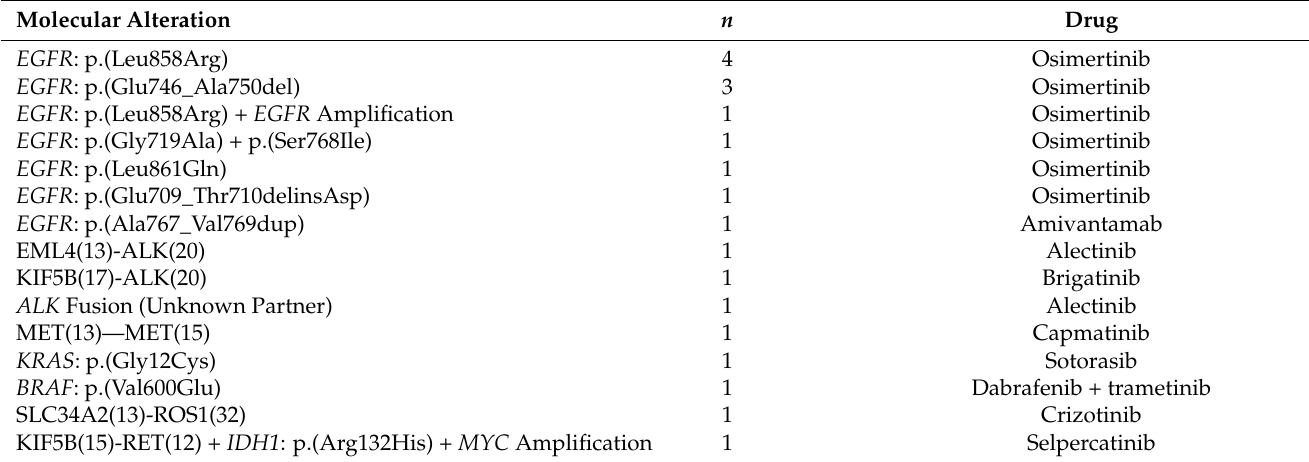
Table 2. Patients with stage IV NSCLC treated with targeted therapies based on the NGS results.